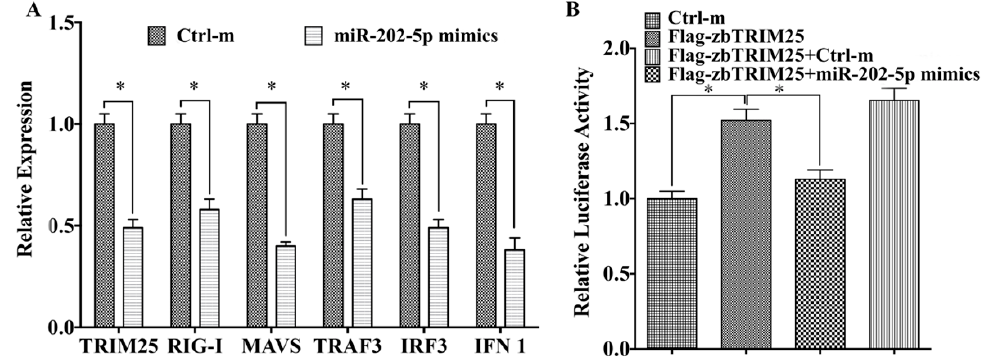
Figure 6. miR-202-5p suppresses zbTRIM25 expression and its downstream signaling. ( A ) Expression of zebrafish TRIM25 , RIG-I , MAVS , TRAF3 , IRF3 , and IFN 1 mRNA was detected by qRT-PCR in ZBE3 cells that were transfected with miR-202-5p mimics or Ctrl-m for 24 h. ( B ) HEK 293T cells were co-transfected with pGL3-DrIFN 1-pro-Luc , pCMV-Flag-zbTRIM25, and miR-202-5p mimics or Ctrl-m for 48 h, respectively, and luciferase activity was measured. Asterisks indicate the significant differences between groups (*: p < 0.05).